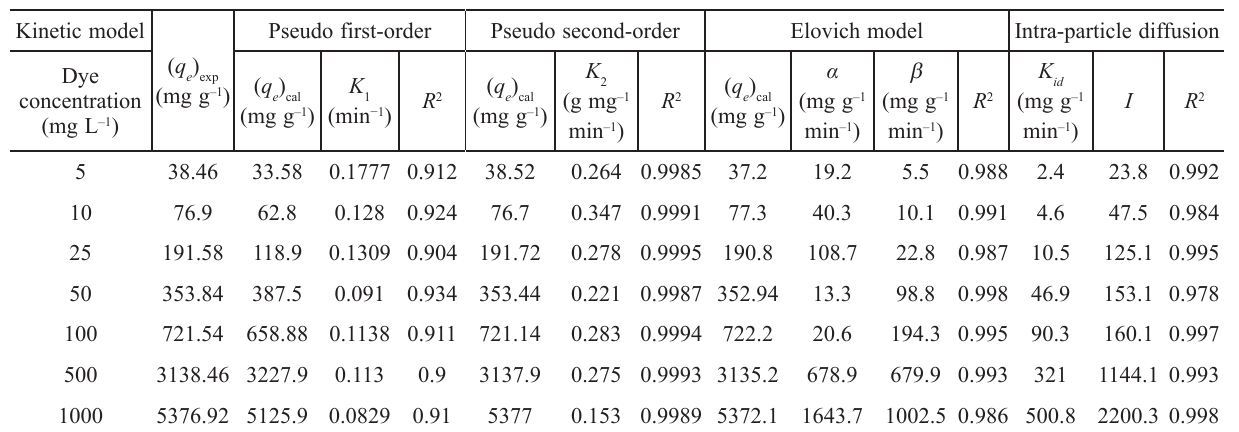
Table 6 – Kinetic parameters of dye adsorption on 40B isolated biopolymer at different dye concentrations Kinetic